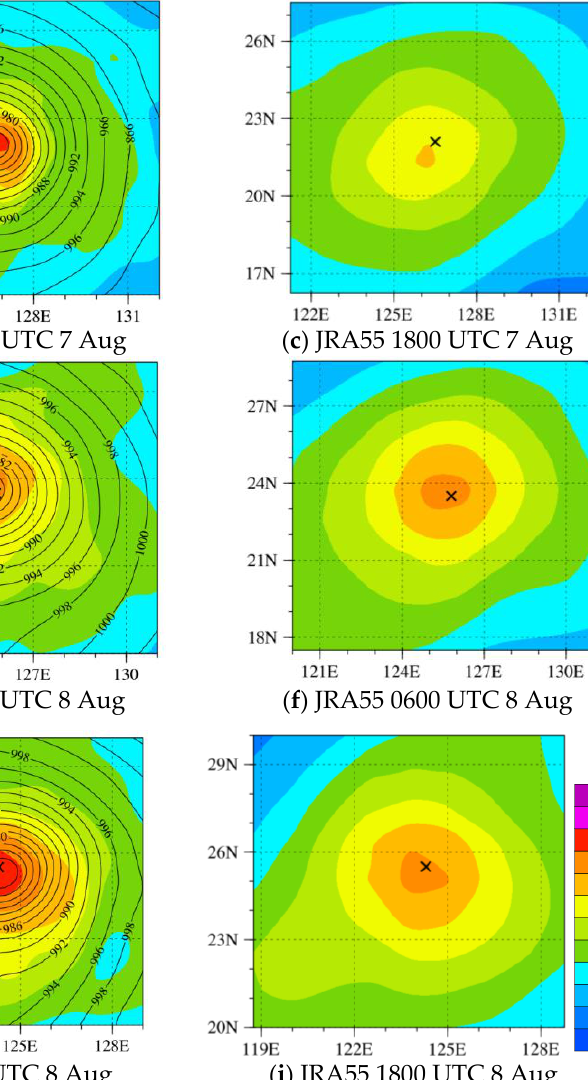
Figure 10. Spatial distributions of FY-4A AGRI channel 12 brightness temperatures (unit: K) at ( a ) 1700 UTC on 7 August 2019, ( b ) 0440 UTC on 8 August 2019, and ( c ) 1700 UTC on 8 August 2019. The black typhoon symbols stand for the best track centers of Typhoon Lekima in Figure 9. We may also compare the vertical structures of warm-cores between the MWTS-2 retrieval and the ERA5 reanalysis. Figure 11 shows the cross-sections of temperature anomalies and potential temperatures obtained from the FY-3D MWTS-2 and the ERA5 reanalysis along a line from west to east passing the best track centers of Lekima at the